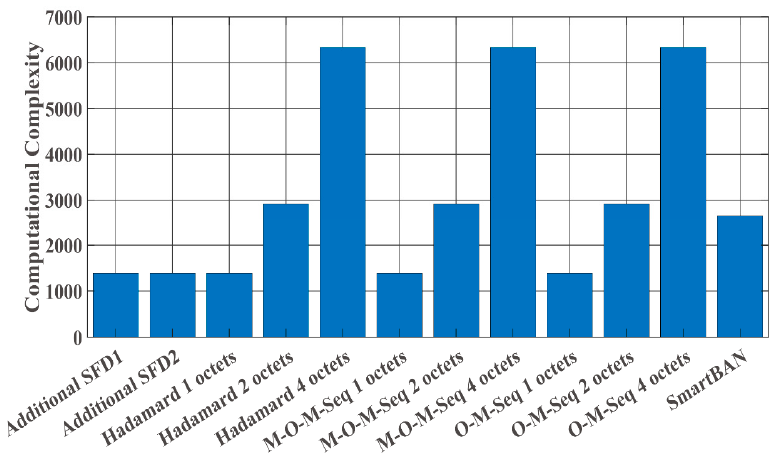
Figure 10. Failure detection ratio under IEEE model CM3 as a function of communication distance.